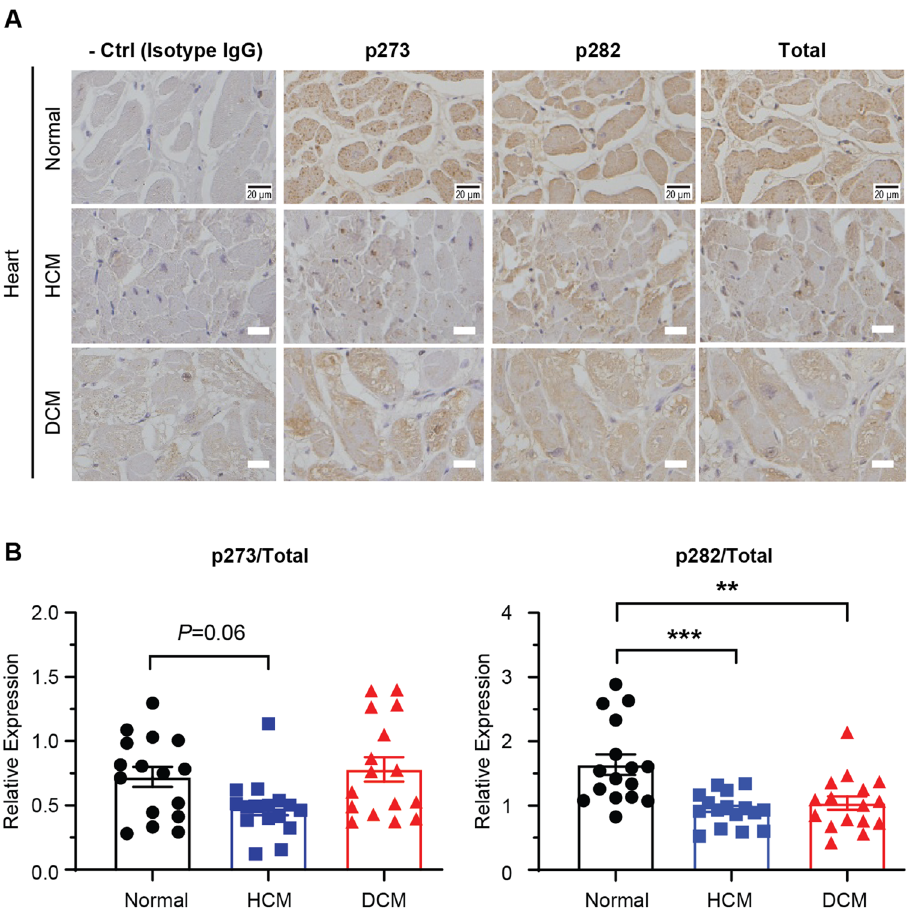
Figure 2. Immunohistochemistry of cardiac tissue sections from HCM and DCM patients showed reduced cMyBP-C phosphorylation compared to healthy donors. ( A ) IHC images of p273 and p282 in normal, HCM, and DCM heart samples. ( B ) Corresponding quantification of p273 and p282 in all heart samples. p273 and p282 values were normalized to total cMyBP-C values. Data represent mean ± SEM (N = 4 patients, n = 16 images). The scale bar in figures represents 20 µm. DCM, dilated cardiomyopathy; HCM, hypertrophic cardiomyopathy: IHC, immunohistochemistry. ** p < 0.01; *** p < 0.005; one-way ANOVA with Tukey post-test.